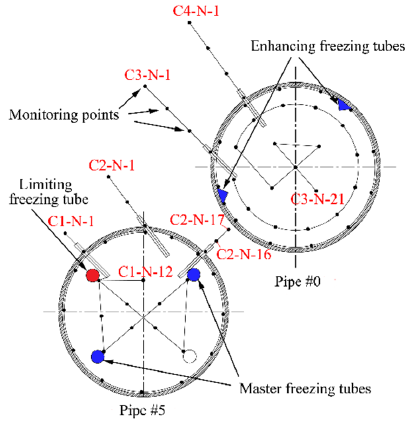
Figure 10 . Position of monitoring points. Figure 10. Position of monitoring